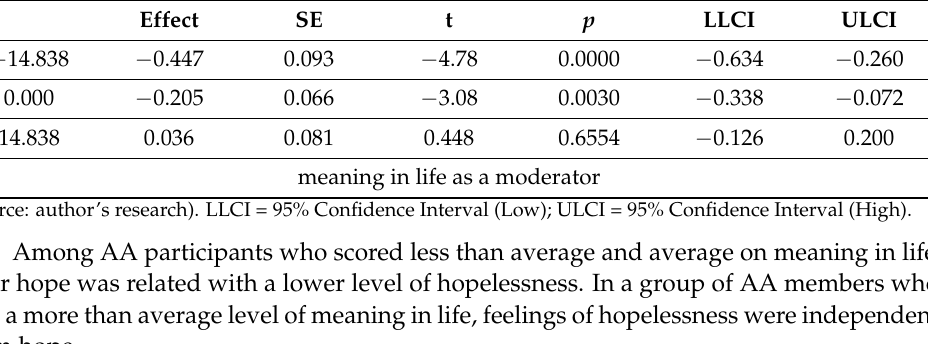
Table 4. Conditional effects of hope at values of moderator (meaning in